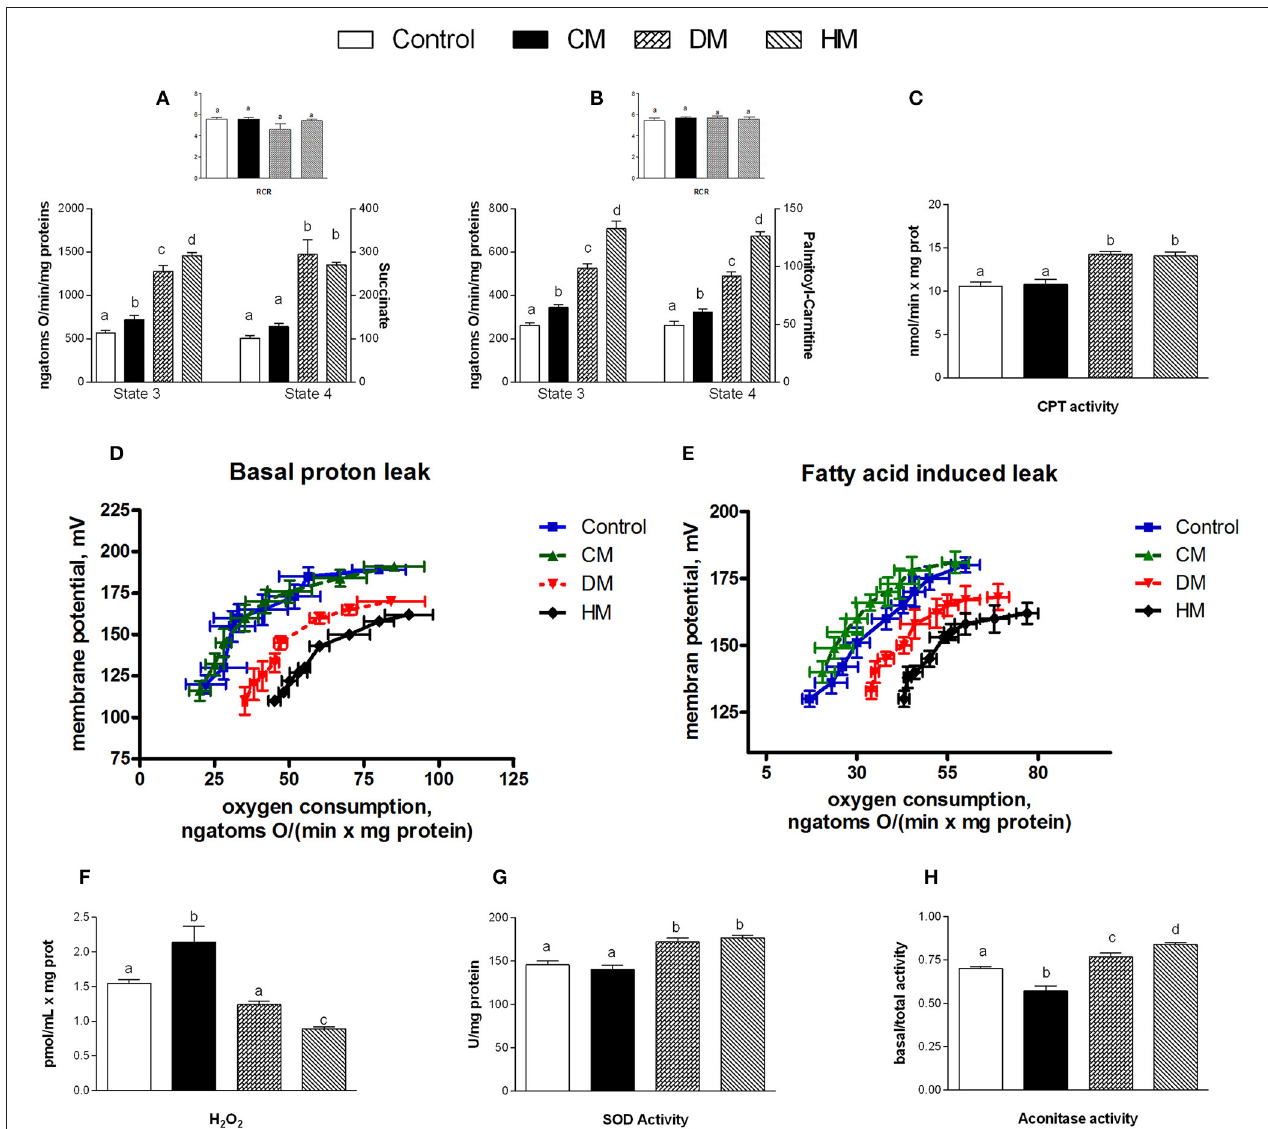
FIGURE 4 | Effects of oral administration of human, donkey, and cow milk on energy efficiency, respiratory parameters, and oxidative stress in mitochondria isolated from skeletal muscle. The graph shows the skeletal muscle mitochondrial respiration rates measured in the presence of succinate (A) or palmitoyl-carnitine (B) as substrates, and the relative RCR ( A,B inset), the carnitine-palmitoyl transferase (CPT) activity (C) , the basal (D) , and fatty acid-induced (E) proton leakage, H 2 O 2 yield (F) , the superoxide dismutase (SOD) activity (G) , and the basal aconitase/total aconitase ratio (H) . Data are presented as means ± SEM from n = 7 animals/group. Labeled means without a common letter differ ( P <